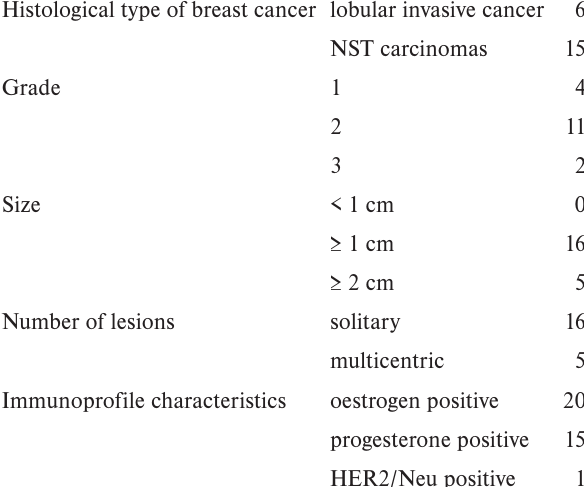
Table 2. The number of positive sentinel node biopsies depending on type of primary breast